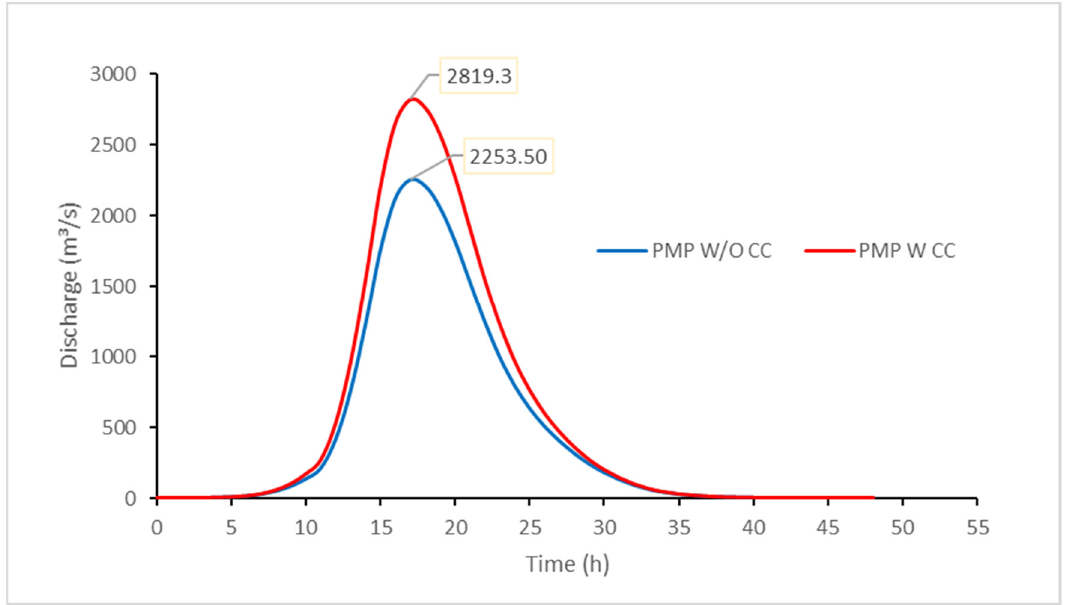
Figure 7. Flood hydrograph for the probable maximum precipitation with (PMP W CC) and without climate change (PMP W/O CC).